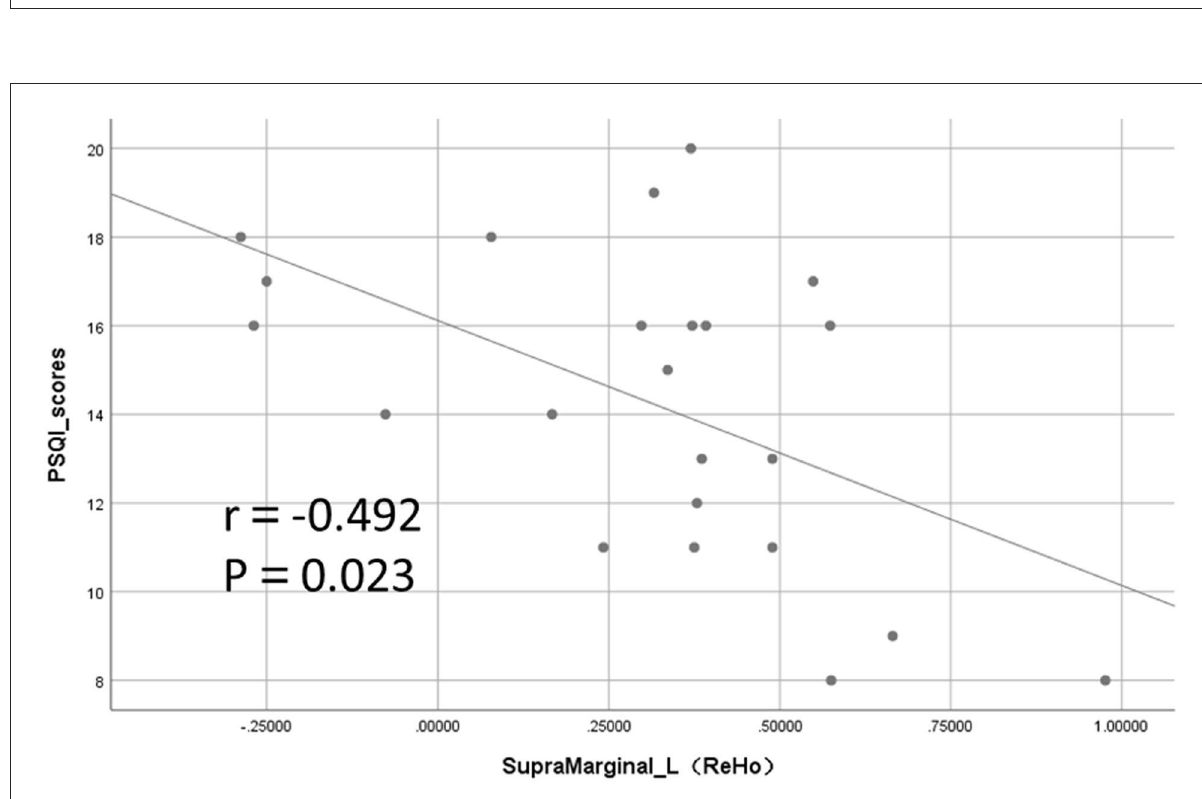
FIGURE5 Significant negative correlation between regional homogeneity (ReHo) values and Pittsburgh Sleep Quality Index (PSQI) total score in the left supramarginal